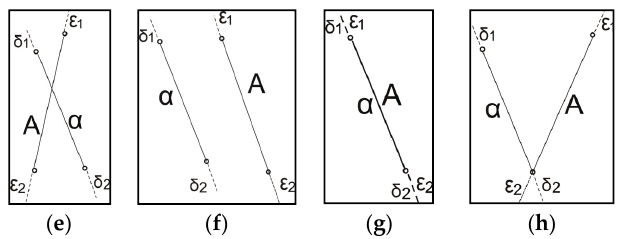
Figure 5. True and false topological relations between SGRPMs. ( a , e ) remain the intersection after being shortened and extended by an arbitrarily small amount; ( b , f ) remain disjoint after being shortened and extended by an arbitrarily small amount; ( c , g ) remain equal after being shortened and extended by an arbitrarily small amount; and ( d , h ) have different topological relations after being shortened and extended by an arbitrarily small amount: this represents a false topological relation in RPCs.